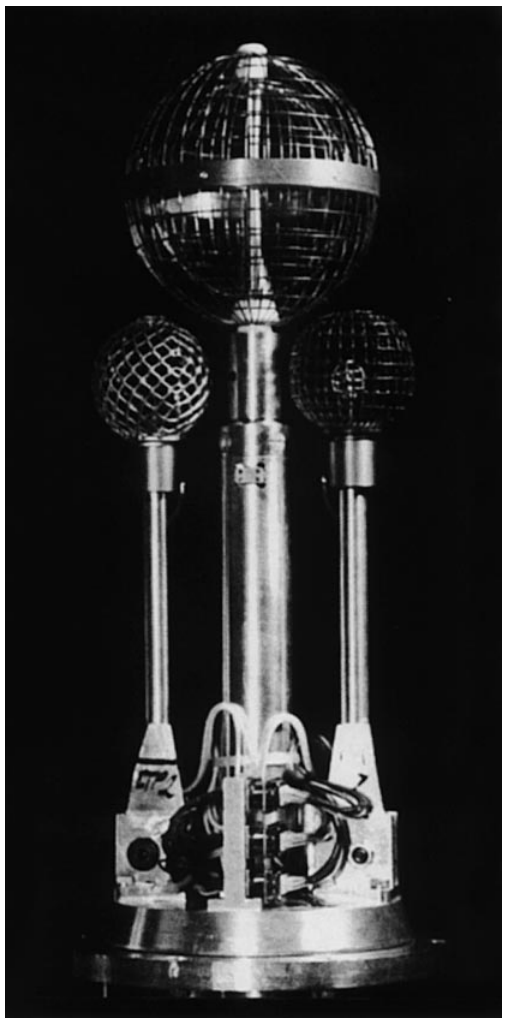
Fig. 1. The instrument in the ISBJØRN 1 payload. A central positive ion probe (PIP) and two cold plasma probes (CPP) were mounted under a split nose cone and released to the atmosphere 60 s